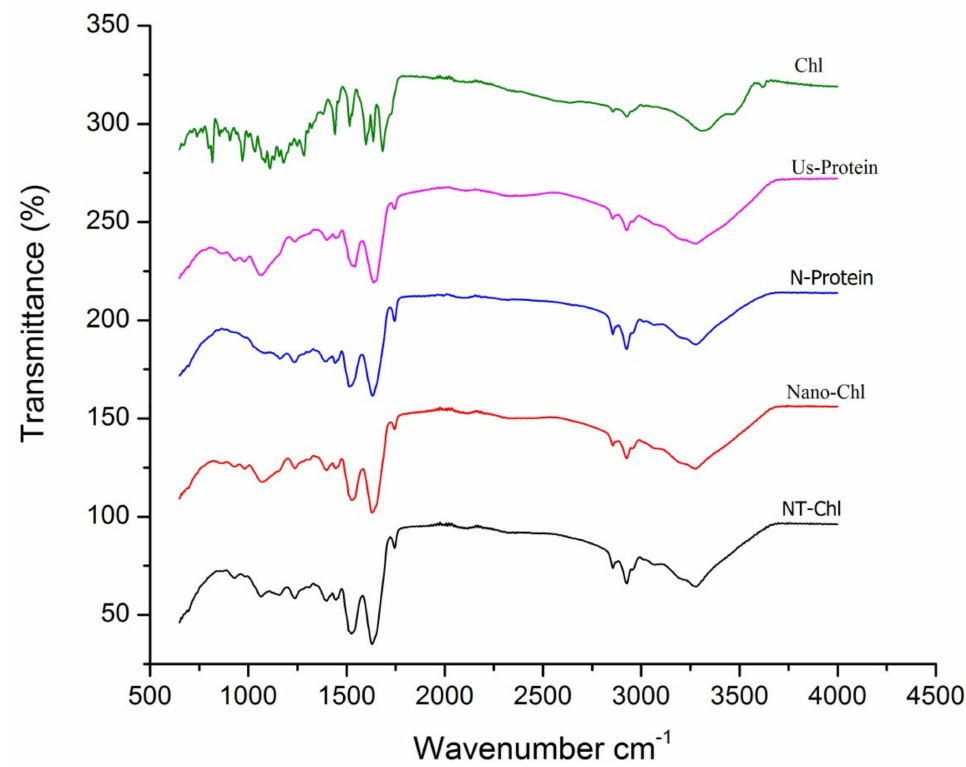
Figure 3. FTIR spectrum of Native apple seed protein (N-Protein), Ultrasonicated apple seed protein (Us-Protein), Chlorogenic acid (Chl), chlorogenic acid loaded in native apple seed protein (NT-Chl) and chlorogenic acid loaded in nano apple seed protein